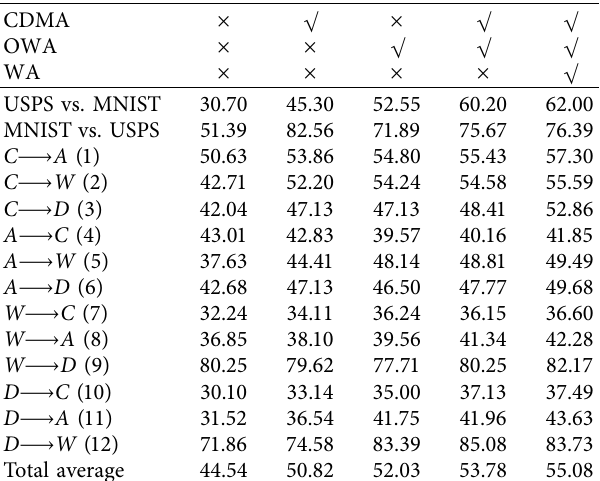
Table 5: Ablation study on diferent mechanisms of JTELM on USPS +MNIST and Ofce +Caltech